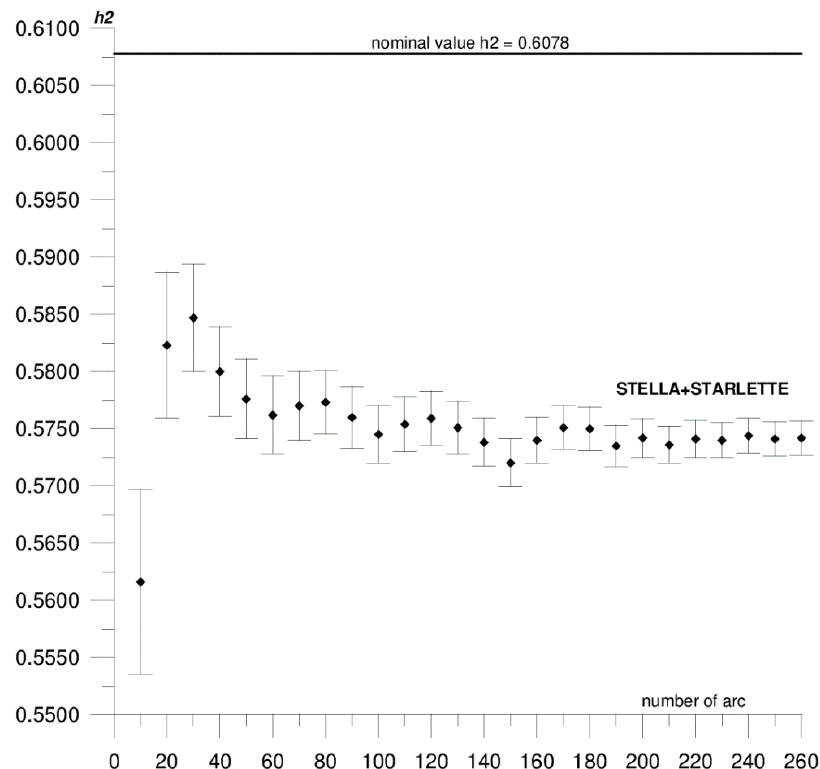
Figure 2. Sequential solution for the Yarragadee local h 2 parameter based on LAGEOS-1+LAGEOS-2 data.